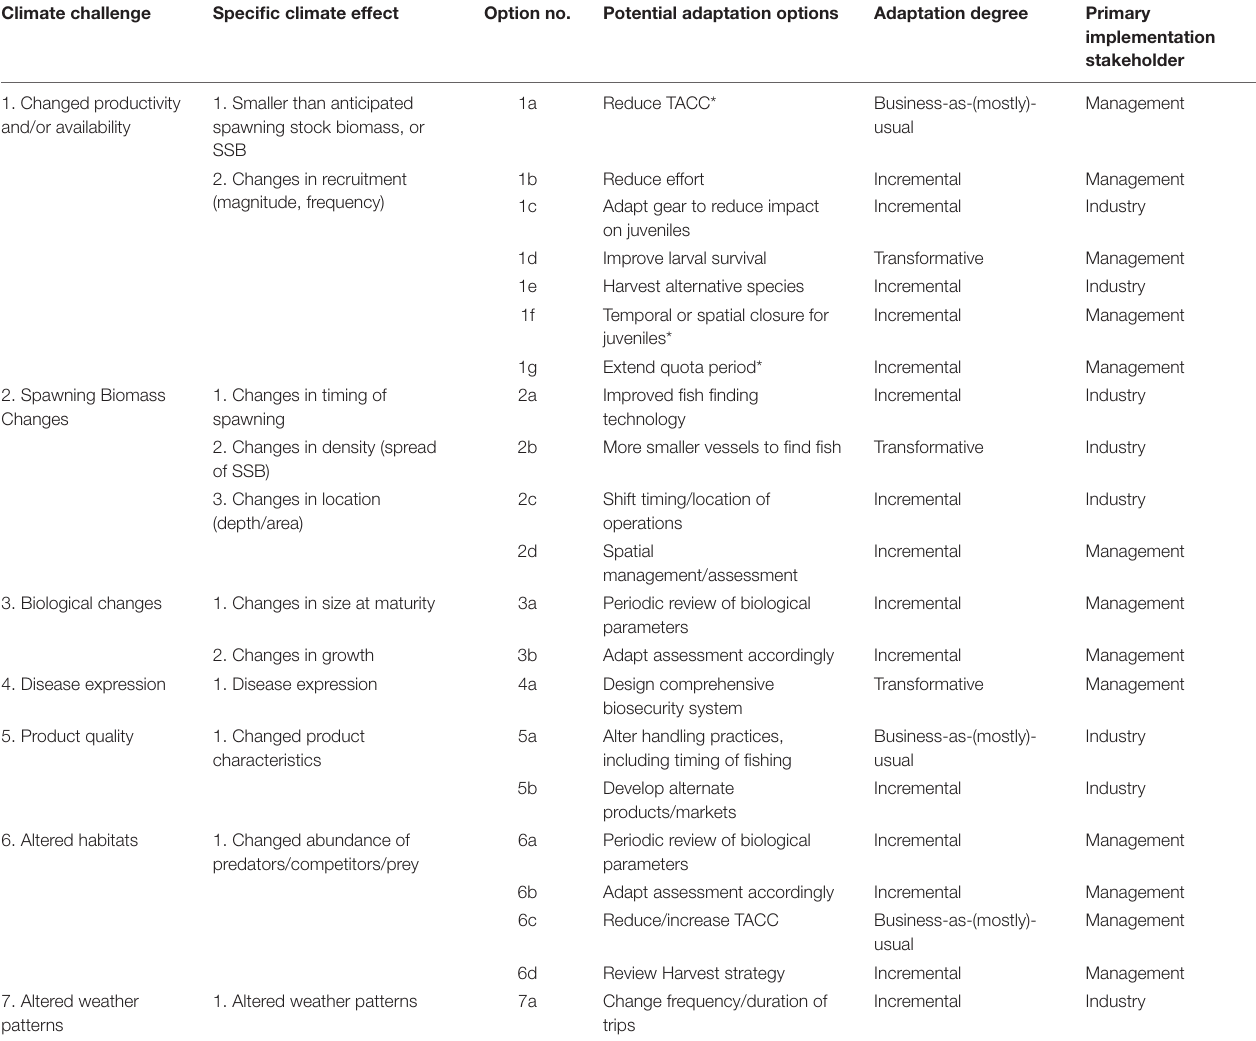
TABLE 3B | Summary characterization of adaptation options identified for Blue grenadier. Climate